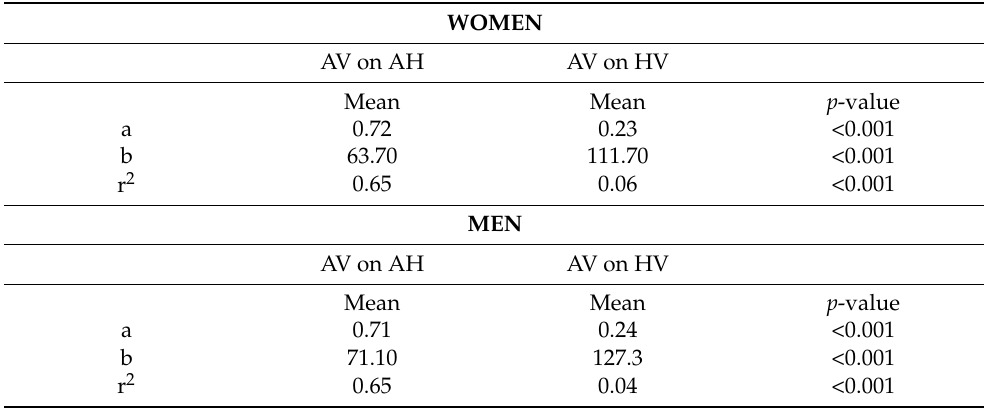
Table 5. Comparison of differences in the regression lines for AV~AH and AV~HV in men and women.